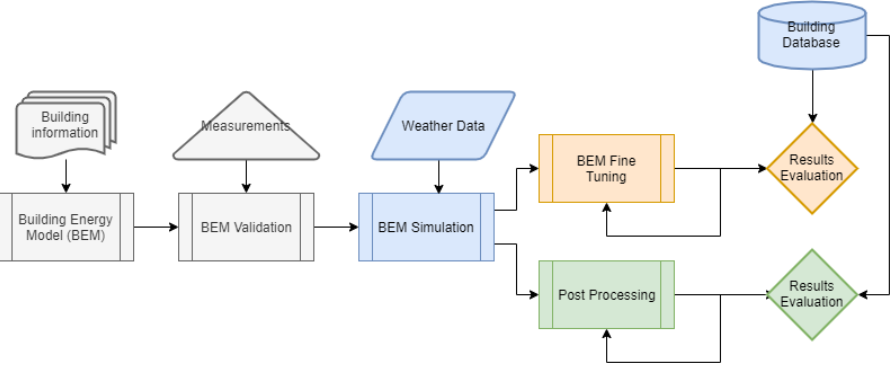
Figure 1. Flowchart of the high level methodology